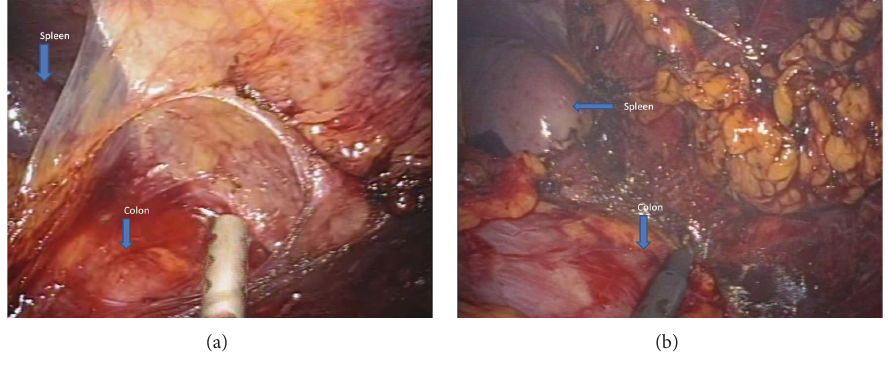
Figure 2: Splenic flexure mobilization.